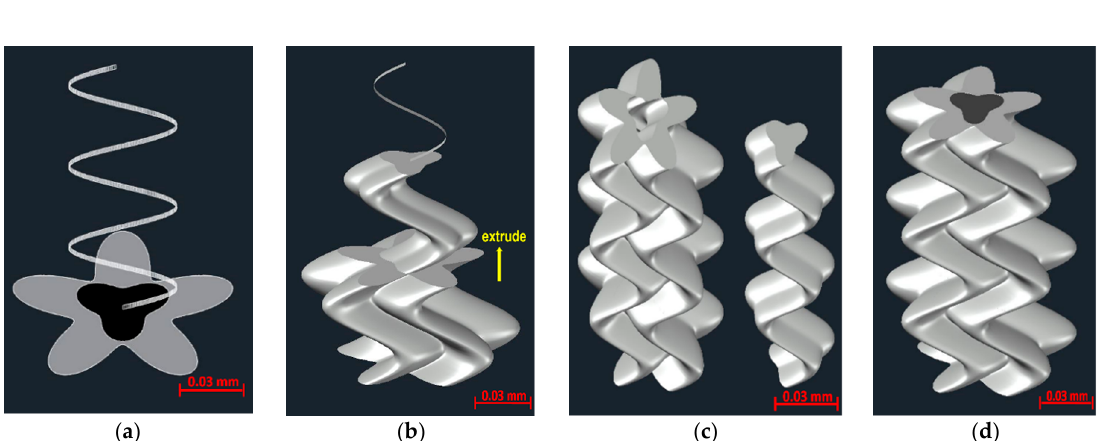
Figure 6. Process for construction of a 3D domain with a separated pore and a tortuous flow channel in case of Berea sandstone. ( a ) 2D surface each feature of pore shape and 3D spline of tortuous flow path; ( b ) extrusion of the surface along the z -axis spline; ( c ) two separated domains with P ap and P indis ; ( d ) coupled flow regime with the two domains. Table 5. Macroscopic parameters of Brinkman equation for the P indis domain properties.